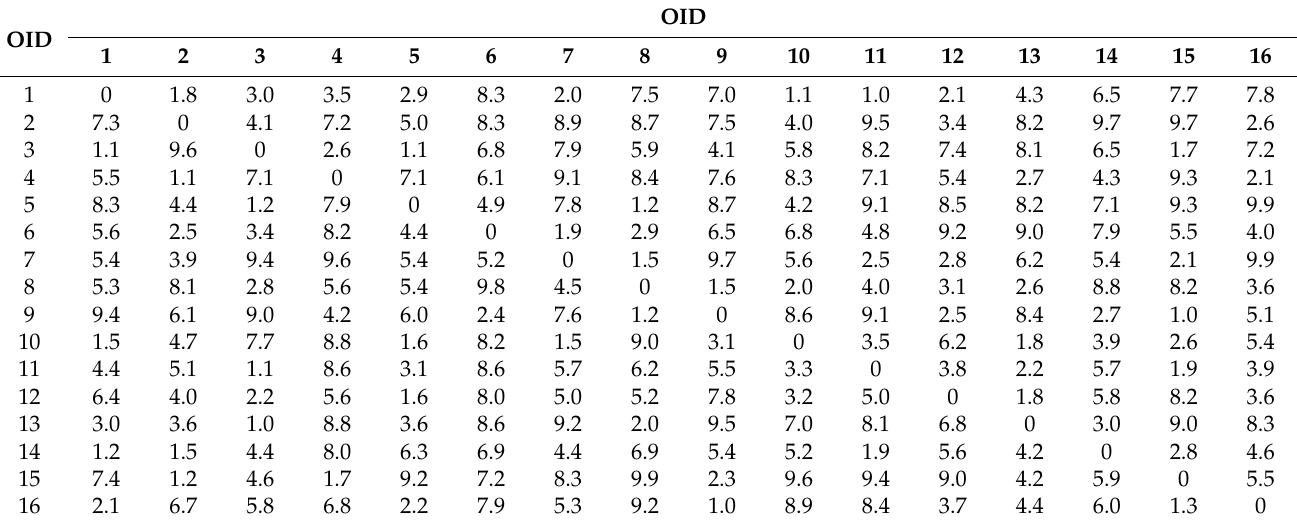
Table 3. Changeover time between production operations (OID = Production order ID) [min]. OID